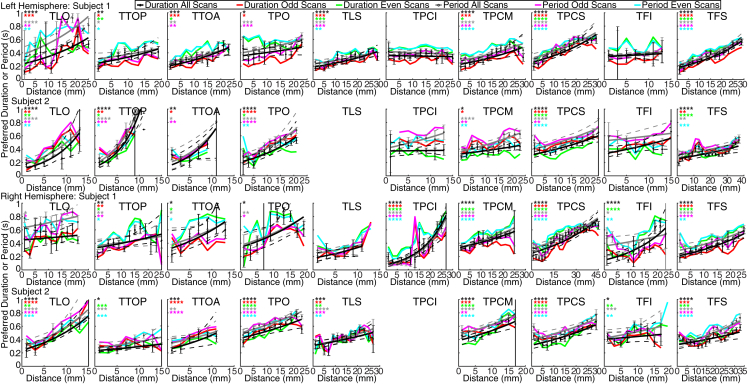
Quantifying Topographic Progressions of Timing Preferences across the Cortical SurfaceProgressing across each map in Figures 3B and 3C (from fine to coarse dashed white lines) reveals gradual topographic progressions of preferred duration and period (fit lines and points) that are reproduced across repeated measures (colored lines). See also Figure S4. ∗p < 0.05, ∗∗p < 0.01, ∗∗∗p < 0.001, ∗∗∗∗p < 0.0001. Points show bin mean values; error bars show SEs.